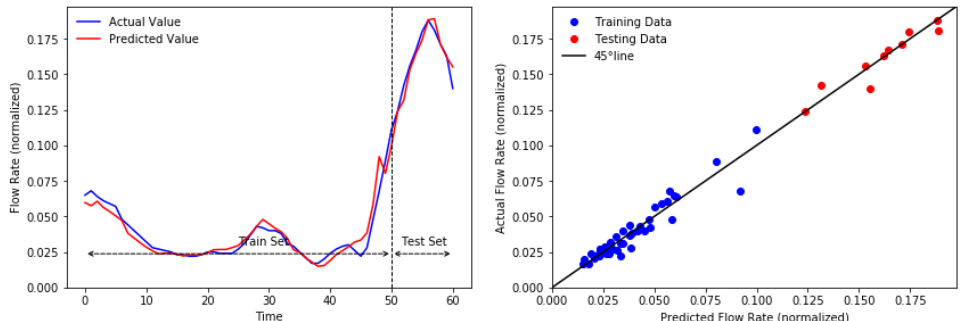
Figure 5. Prediction result of EMD-BP-MLMVN for CB2.